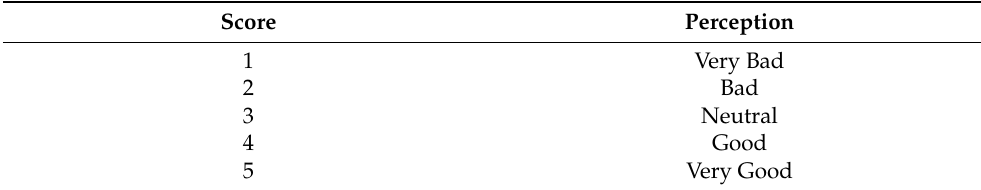
Table 4. Validation